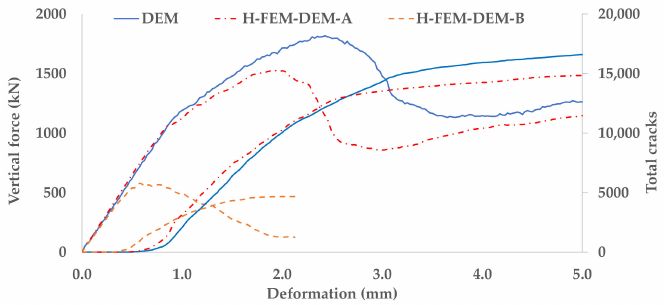
Figure 16. Uniaxial compression tests in Rubble wall: force displacement